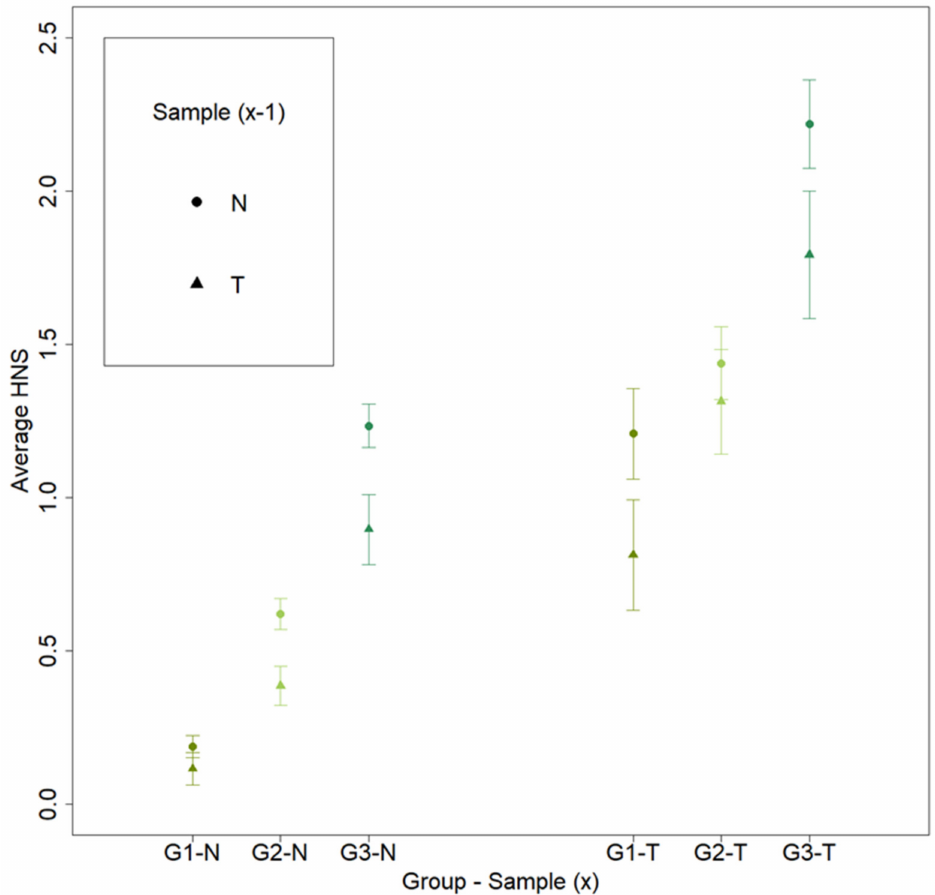
Figure 5. Average score (HNS) for each sample type (x) and previous sample type (x-1) per participant group, consisting of (1) “G1—trained” (6 trained panelists), (2) “G2—familiar” (6 people had some notion of AND and / or SKA, and / or boar tainted samples in general but who were not trained), and (3) “G3—unfamiliar” (6 people who had no notion of boar taint). The average score given by participants for all sample types increases progressively for participant groups with decreasing familiarity with boar taint. For all groups of participants, average score was lower if the preceding sample was tainted. Table 3. Inter and intra rater reliability, and sensitivity and specificity for each participant group (G1: trained, G2: familiar, G3: unfamiliar) for cuto ff score 1, 2 and 3. G1 G2 G3 All Inter rater reliability 0.45 0.29 0.16